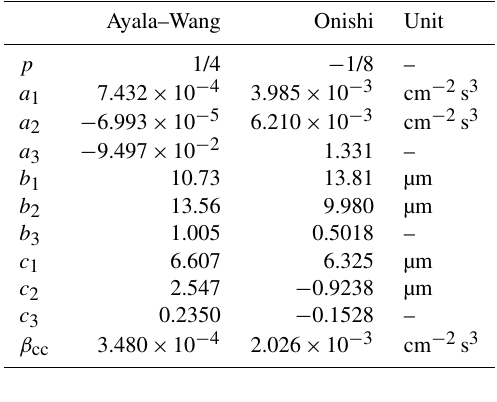
Table 1. Coefficients as a result of the nonlinear regression for k cc as given by Eqs.